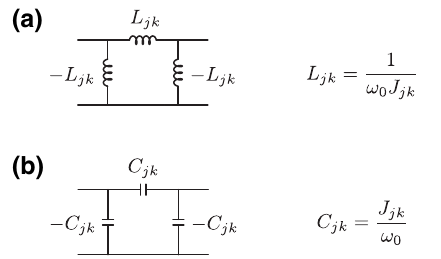
FIG. 11. Lumped-element physical implementations of an admittance inverter, using (a) an inductive π section and (b) a capacitive π